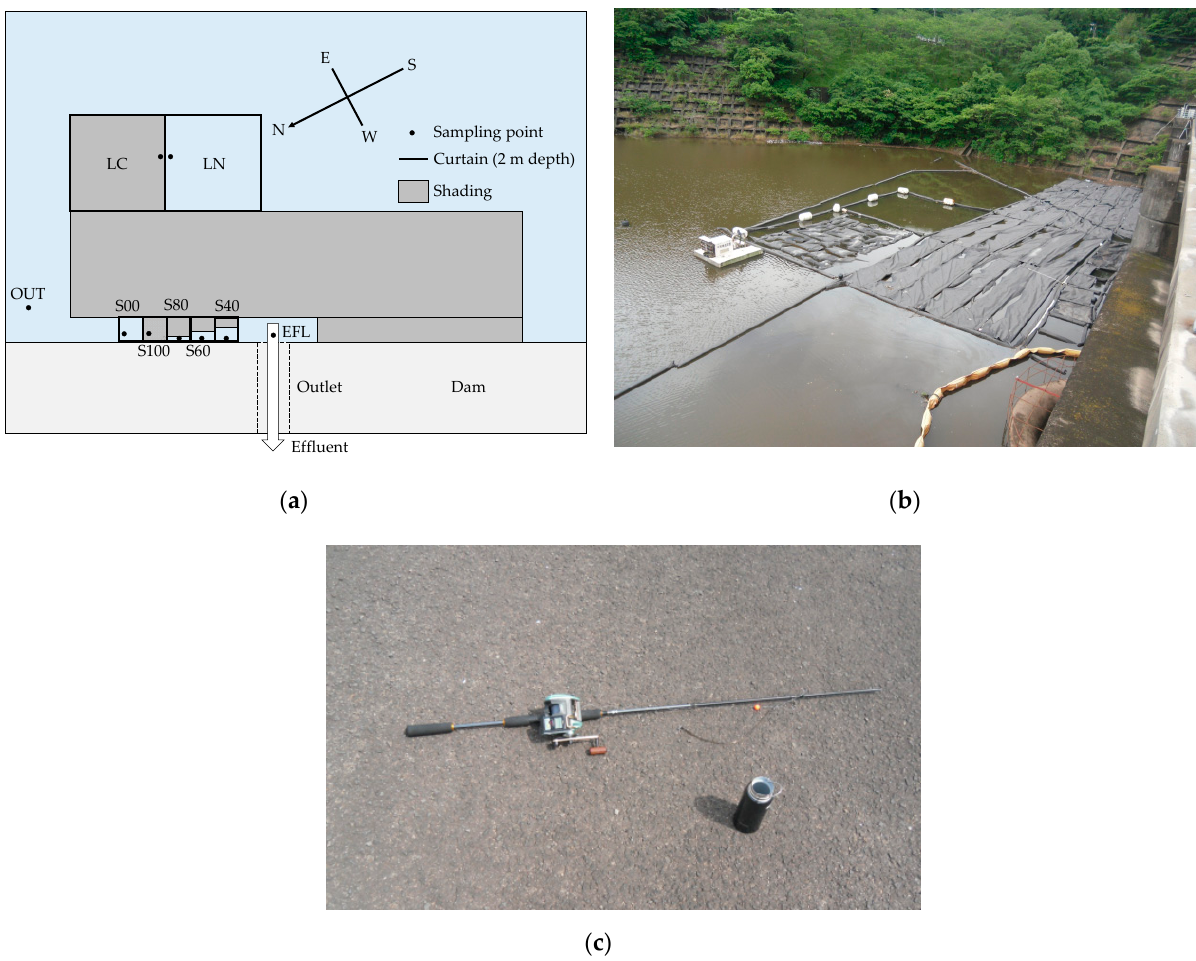
Figure 4. ( a ) Schematic diagram of shaded sections; ( b ) Photograph of the sections (direction: from OUT to LN in ( a )); ( c ) Water sampling equipment. Table 1. Shading conditions.